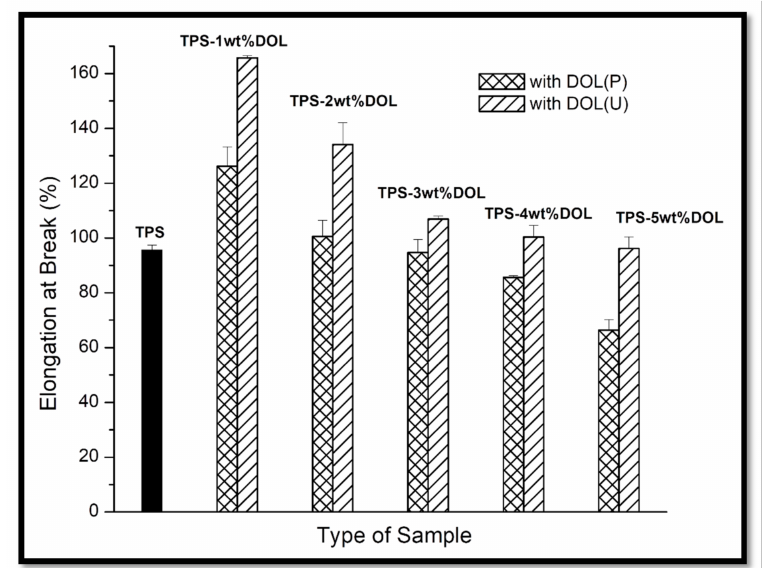
Figure 11. Elongation at break of TPS film and TPS-DOL biocomposite films.